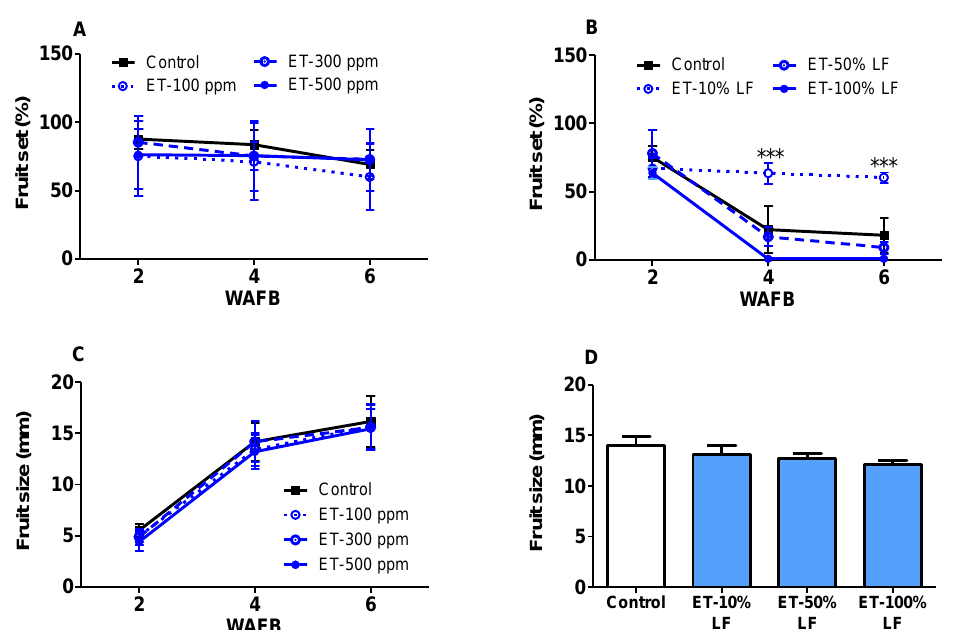
Figure 5. Ethephon effects on fruit set and fruit size of peach cultivars. Fruit set (%) of ‘Redhaven’ ( A ) and ‘Sunhigh’ ( B) was evaluated 2, 4, and 6 WAFB. Fruit size of ‘Redhaven’ ( C ) was measured 2, 4, and 6 WAFB and fruit size of ‘Sunhigh’ ( D) was measured 6 WAFB. Each point or bar represents mean ± SE, each of size n = 12 for fruit set, and n = 30 for fruit size. Asterisks *** represent significant difference between ET treatment and the control at p < 0.001. ET, ethephon; LF, leaf fall; WAFB, weeks after full bloom.